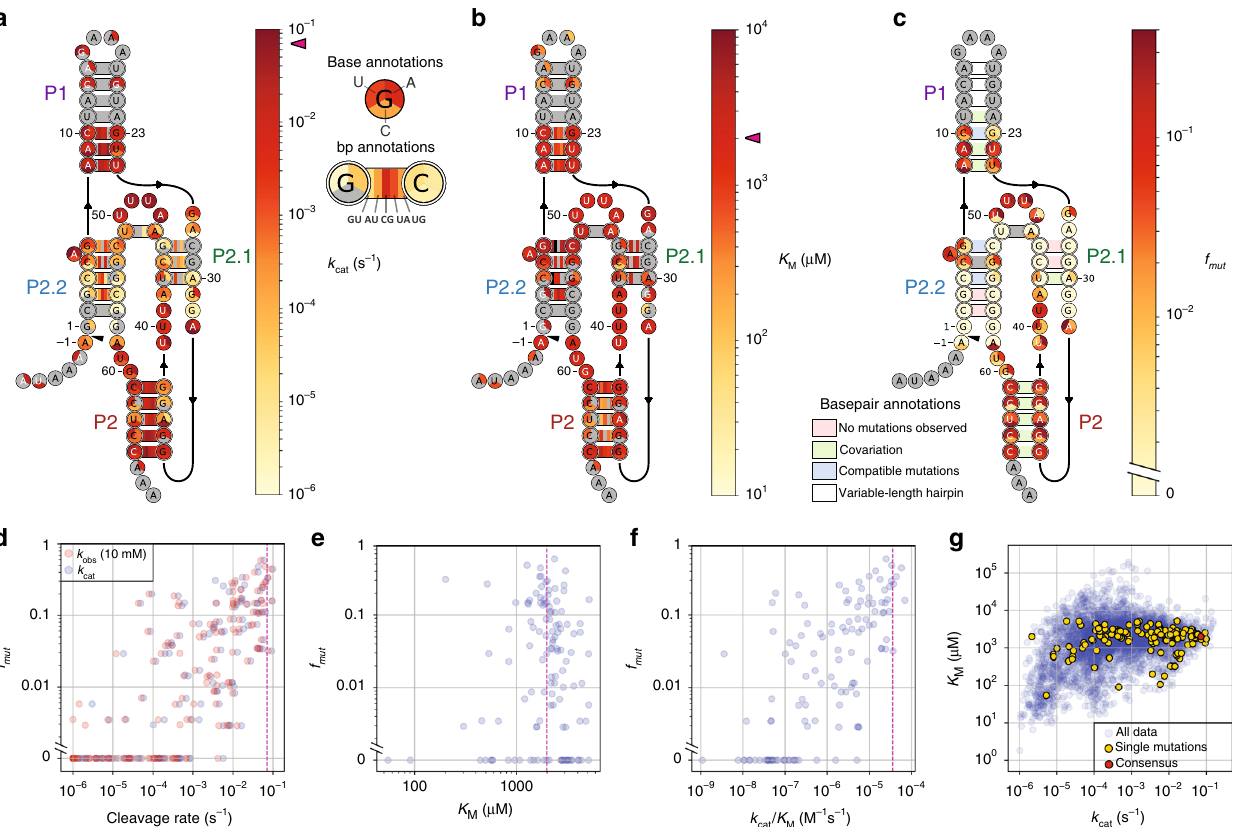
Fig. 2 Mutation frequency is tightly correlated with effects on the cleavage rate. Structural heatmaps of k cat ( a ) and apparent K M ( b ) for all single mutants and basepaired-partner double mutants. Magenta arrowheads indicate consensus ribozyme values. c Structural heatmap of mutation frequency for point mutants, and previously reported basepair covariation, from ref. 9 (Methods). d – f Scatterplots of mutation frequency vs. cleavage rate ( d ), K M ( e ), and k cat / K M ( f ) for point mutants of the ribozyme core. Dotted magenta lines indicate consensus ribozyme values. g Scatterplot of K M vs. k cat for all variants for which both parameters were determined. Source data are available in the Source Data fi le.